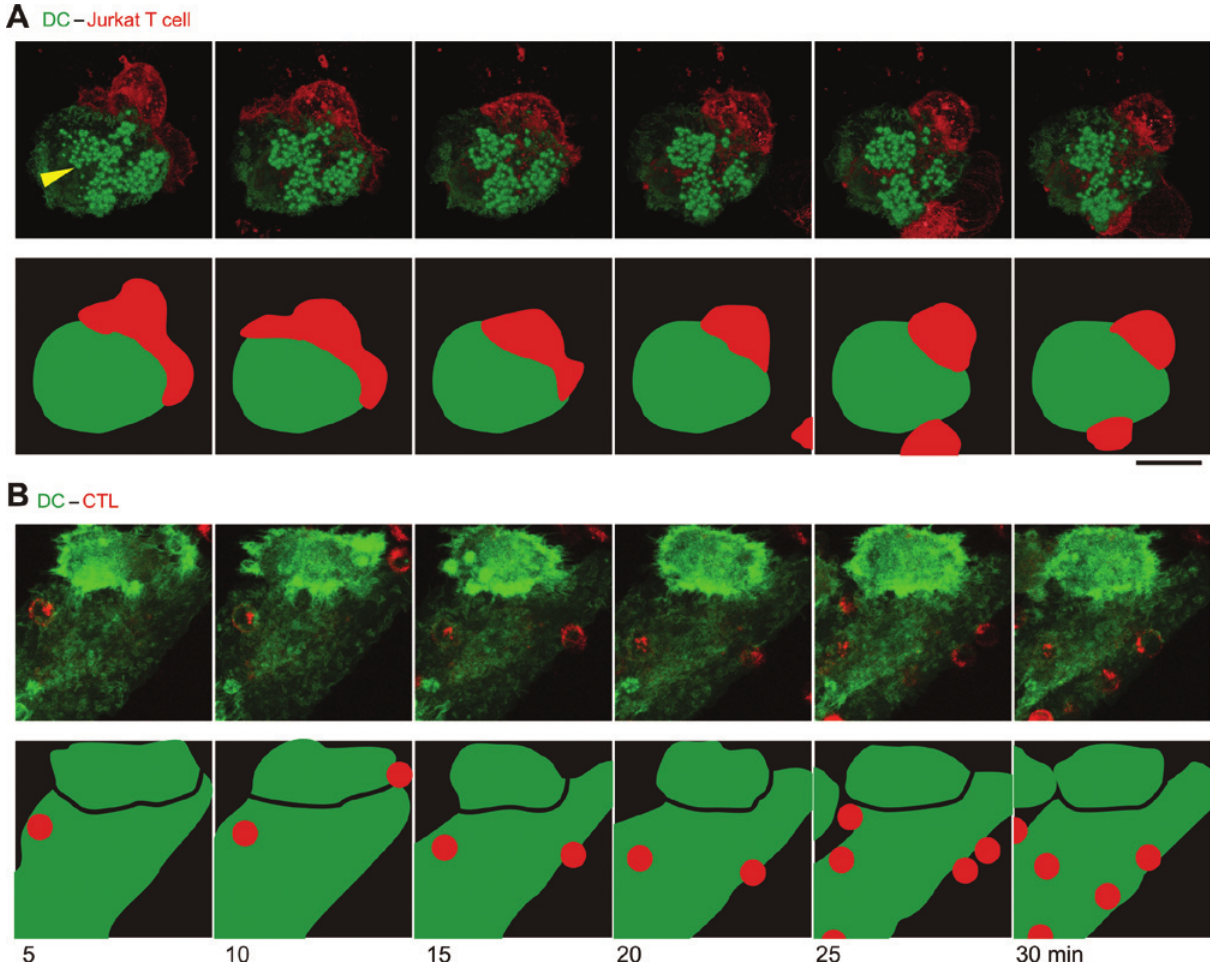
Figure 1: Structural differences in DC immunological synapses with Jurkat or primary T cells. (A) An antigen specific synapse between a Jurkat T cell (red) and a DC differentiated from peripheral blood mononuclear cells (green). Jurkat T cells were heterologously expressing a TCR recognizing a tumor antigenic peptide (gp100 residues 280–288) (64). DCs were expressing the actin binding protein LifeAct fused to GFP (green), as described (108), and were loaded with an excess of antigenic gp100 peptide. The Jurkat T cells were labeled with a far-red fluorescent membrane marker (red). The bright F-actin rich structures in the DC are podosomes (marked with a yellow arrowhead for t = 5 min) (108). The upper row shows z -projections of confocal stacks recorded at the indicated time points after T cell addition. The lower row shows the schematic outline of the cells. Note that the Jurkat T cell first spreads out covering a large area of the DC surface and this is followed by cellular contraction. (B) Same as panel A, but now with primary CD8 + T cells transfected with the same TCR recognizing tumor antigen from gp100 (64). Primary T cells are much smaller ( ~ 5–10 μ m diameter) than Jurkat T cells (20–50 μ m diameter). Note that with primary T cells, the DCs (but not the T cells) show large structural deformations and cover large areas of the surface of the T cells. Scale bar: 20 μ